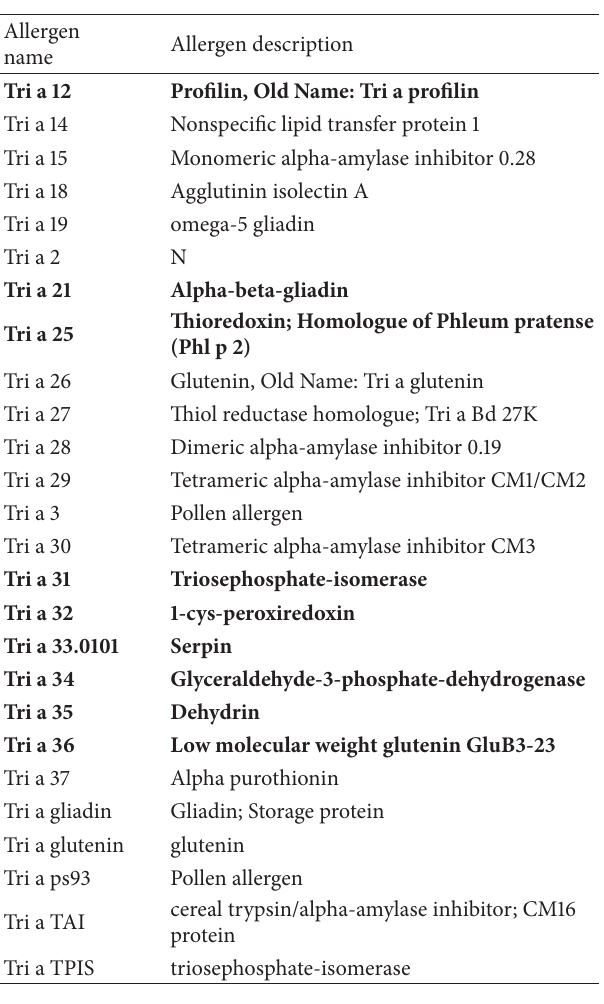
Table 1: Wheat allergens from SDAP website. Highlighted in bold, the allergen selected for molecular